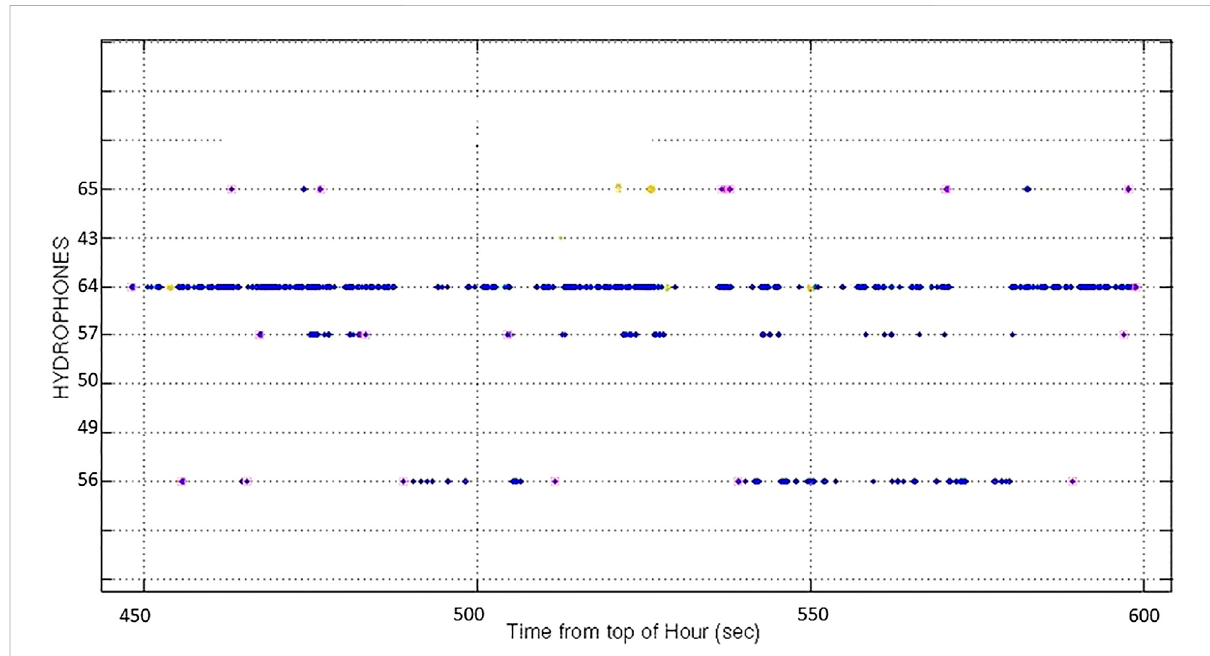
FIGURE 3 Output of AUTEC CS-SVM classi fi er showing a Md click train as received on hydrophone 64 and neighbouring hydrophones. Blue dots indicate thetimeofMdforagingclickdetectionsonagivenhydrophone(listedonverticalaxis).Magentasquaresindicatethe fi rstandlastclicksinaclicktrain according to the rules on the CTP. According to the rules of the AG, these trains would be joined together to form a single group